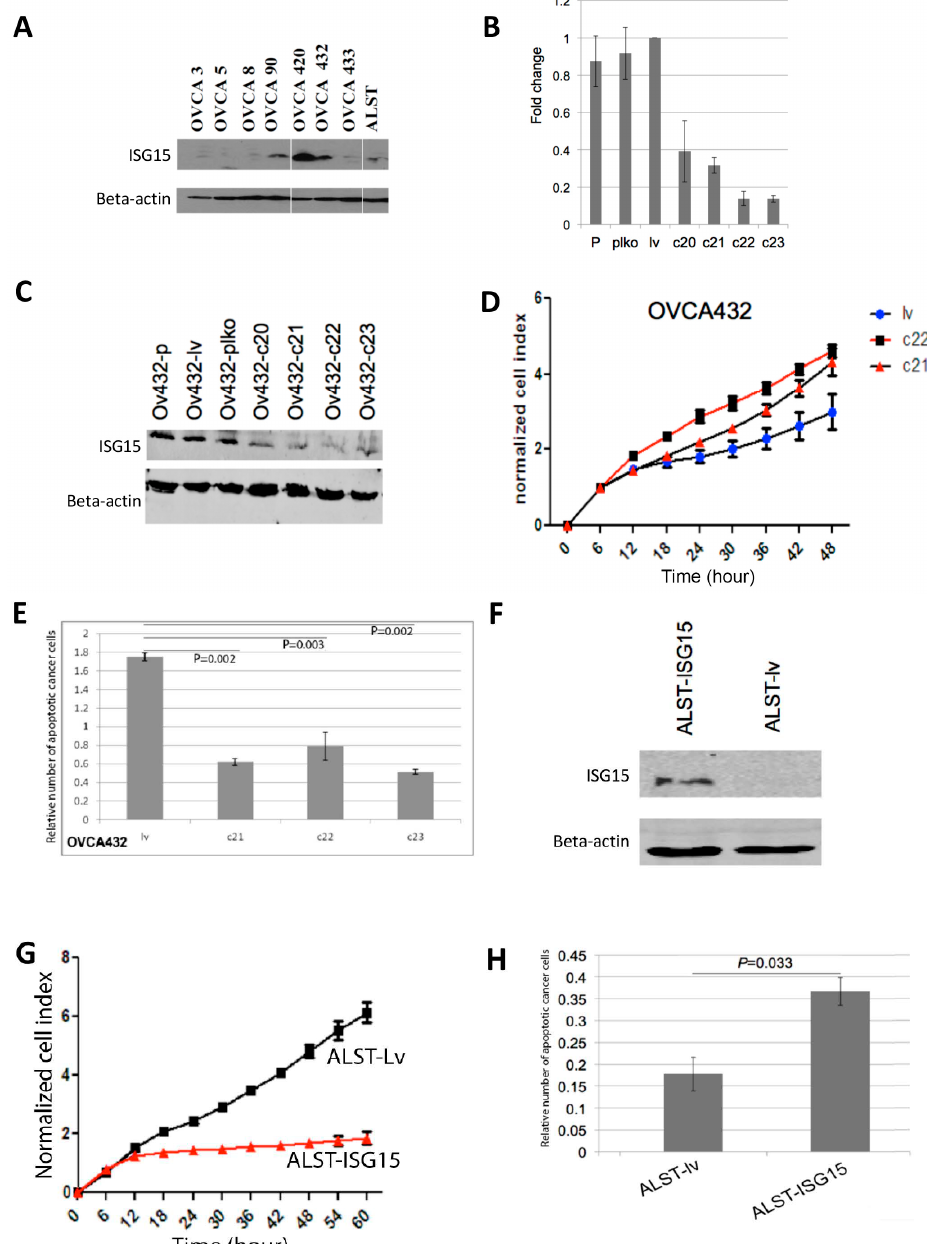
Figure 3. Endogenous ISG15 expression suppresses ovarian cancer growth and induces apoptosis in vitro. ( A ) Endogenous ISG15 expression levels were evaluated in eight ovarian cancer cell lines by Western bolting analysis. ISG15 expression in OVCA432 ovarian cancer cells was silenced by transduction of ISG15 specific shRNAs. ISG15 silencing was confirmed by ( B ) qRT-PCR and ( C ) Western blot analyses. ( D ) OVCA432 cells transduced with ISG15 shRNAs showed a significant increase in growth rates compared with those transduced with the control construct ( p < 0.001). ( E ) Cell Death ELISA assay demonstrated a significant decrease in apoptosis in OVCA432 cells transduced with ISG15 shRNAs compared with the scramble sequence. ( F ) ALST ovarian cancer cells were transduced with a full-length ISG15 expression construct. Increased ISG15 protein expression in transduced cells were confirmed by Western blot analysis. In vitro experimental results showed a significant ( G ) decrease in growth rate and ( H ) increase in apoptosis in cells transduced with the ISG15 expression vector when compared with those transduced with the control